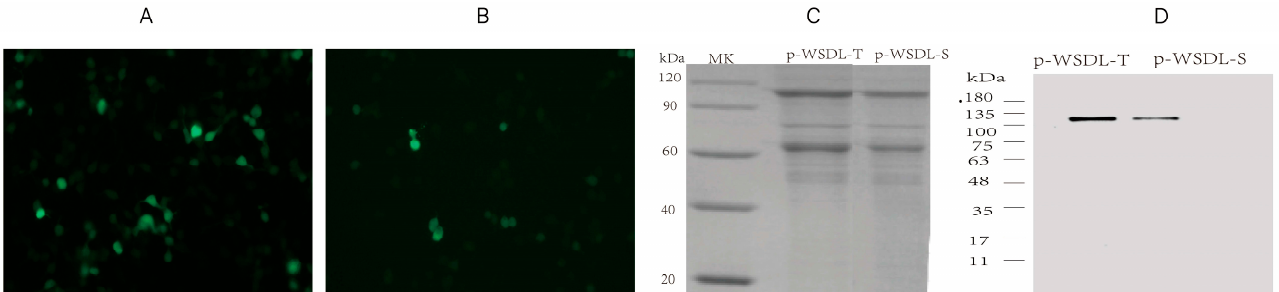
Figure 2. Protein expression analysis: ( A ) The expression of recombinant plasmid WSDL-T-EGFP in transfected HEK293T cells. ( B ) The expression of recombinant plasmid WSDL-S-EGFP in transfected HEK293T cells. Images were analyzed with a fluorescence microscope with a 20 × objective. ( C ) SDS– PAGE and ( D ) western blot assay to detect the purified protein of DNA vaccines (p-WSDL-T and p-WSDL-S) bearing four RBD regions expressed in ExpiCHO cell lines.